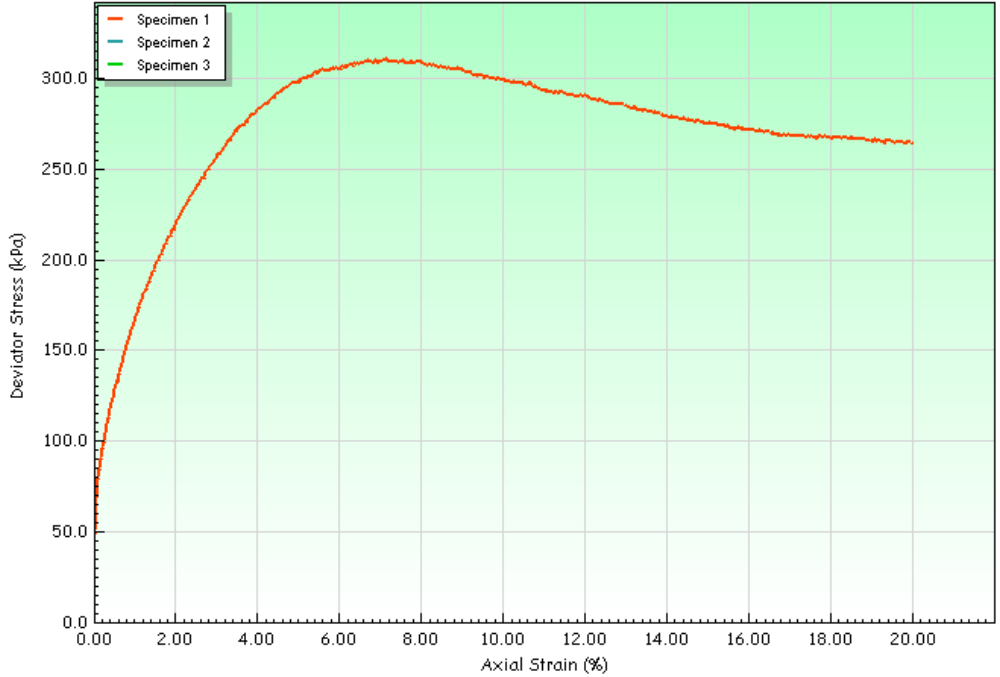
Figure A8. Deviatoric stress during testing of sample of regenerated sand in triaxial compression apparatus.